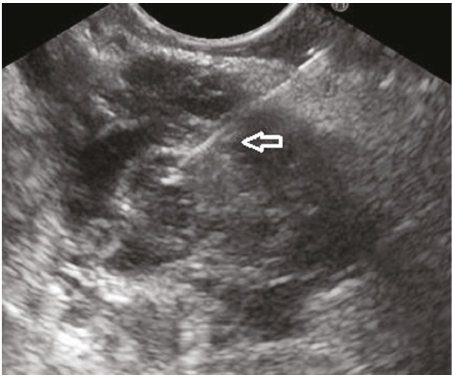
Figure 2: Main duct intraductal papillary mucinous neoplasia, FNA performed (arrow pointing at the FNA